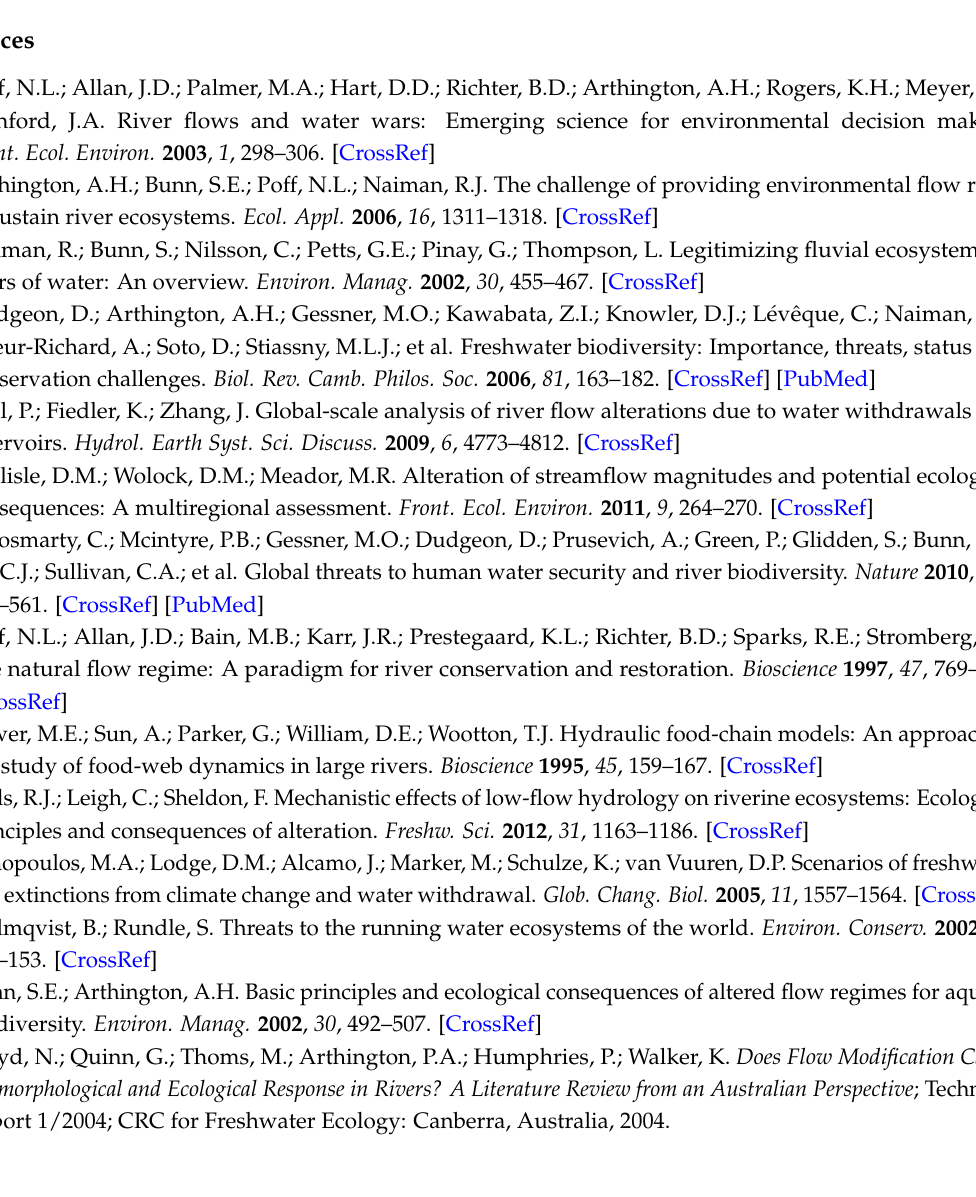
Figure S1: Annotated workflow for development of flow–ecology relationships used in the case study, Table S1: Interquartile ranges defining hydrologic reference conditions for the Cumberland Plateau in northern Middle Tennessee and southeast Kentucky, Figure S2: Flow–ecology relationships for 138 sites on the Cumberland Plateau of Tennessee and Kentucky, Table S2: Streamflow characteristics, expressed as hydrology departure from reference conditions, used in ecological limit functions for the Cumberland Plateau in northern Middle Tennessee and southeast Kentucky and ecological limit function parameter estimates, Table S3: Streamflow characteristics describing modeled streamflow time-series for water-management scenarios at model Location 1, Table S4: Streamflow characteristics describing modeled streamflow time-series for water-management scenarios at model Location